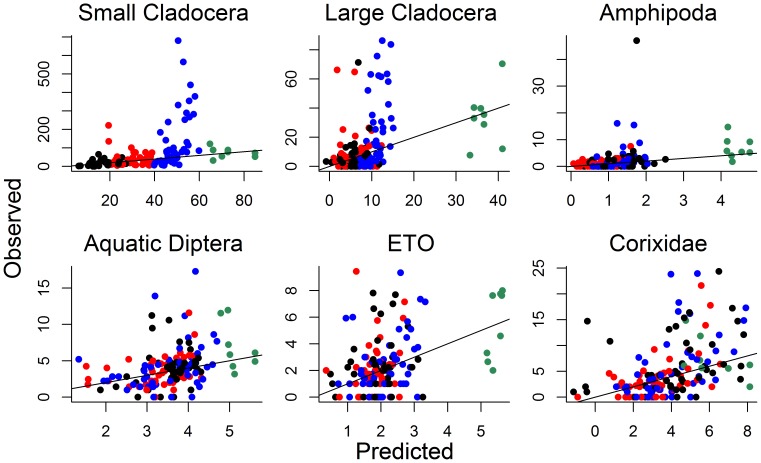
Comparisons of observed and predicted values from regression models.Observed vs. predicted values from fitted (robust regression) models, along with a 1∶1 line. Colors depict different fish classifications: green = fishless, black = planktivores, red = planktivores+benthivores, blue = planktivores+benthivores+piscivores.